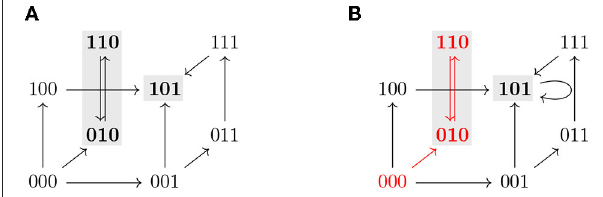
FIGURE 4 | (A) Asynchronous state transition graph of a Boolean function with two attractors, { 101 } and { 010,110 } (marked in gray). (B) TS for the STG shown in (A) . Note that a self-loop has been added in the steady state 101 to have a deadlock-free TS. The states 001, 011, 101, and 111 satisfy the state formula AG φ 3 , where φ i = ( i = 1), while EF φ 3 is satisfied by all the states except 010 and 110. The path that starts at 000 and then oscillates between 010 and 110 (in red) satisfies for instance F φ 2 and G ¬ φ 3 but not G φ 1